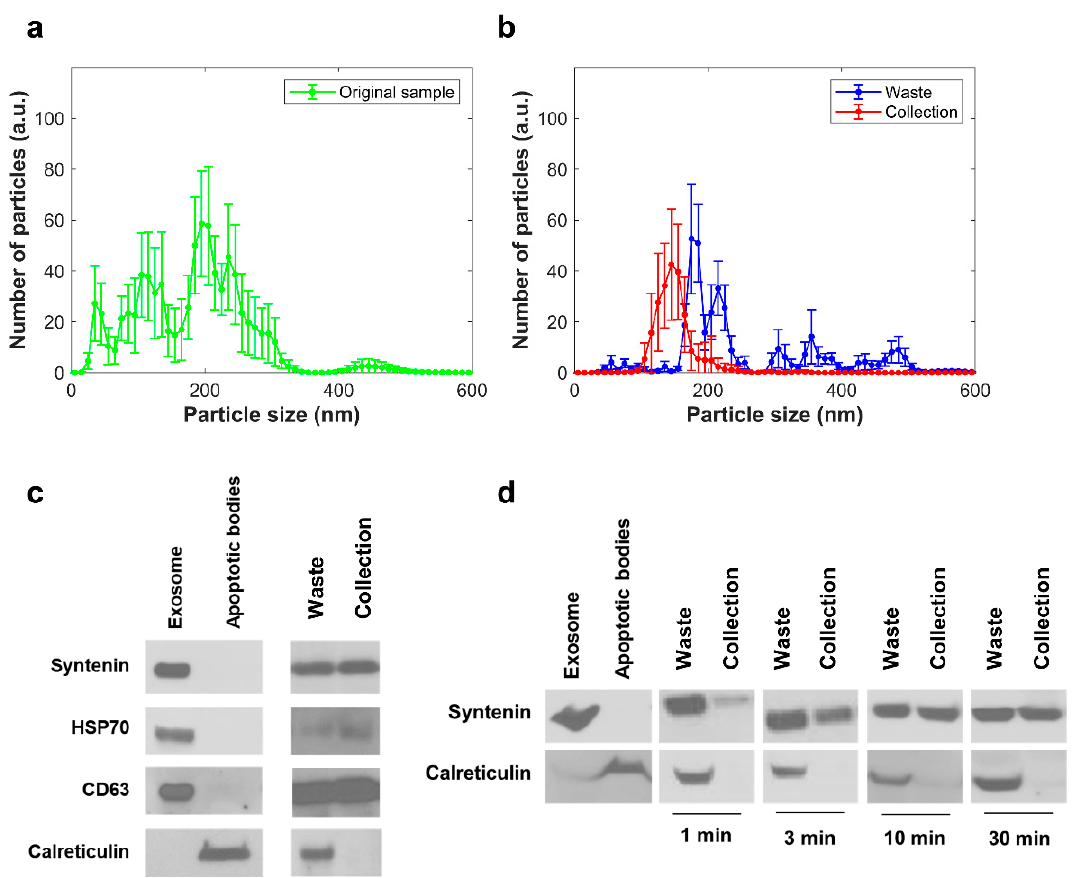
Figure 3. Results for separation of EVs from cell culture media. ( a ) NTA results for mixture of EVs and apoptotic bodies before separation. ( b ) NTA results for the two chambers after separation. ( c ) Immunoblotting results for the two chambers after 6 h of separation. Syntenin, HSP70, and CD63 are biomarkers of exosomes, and calreticulin is a biomarker of apoptotic bodies. ( d ) Immunoblotting results for time-dependent separation.